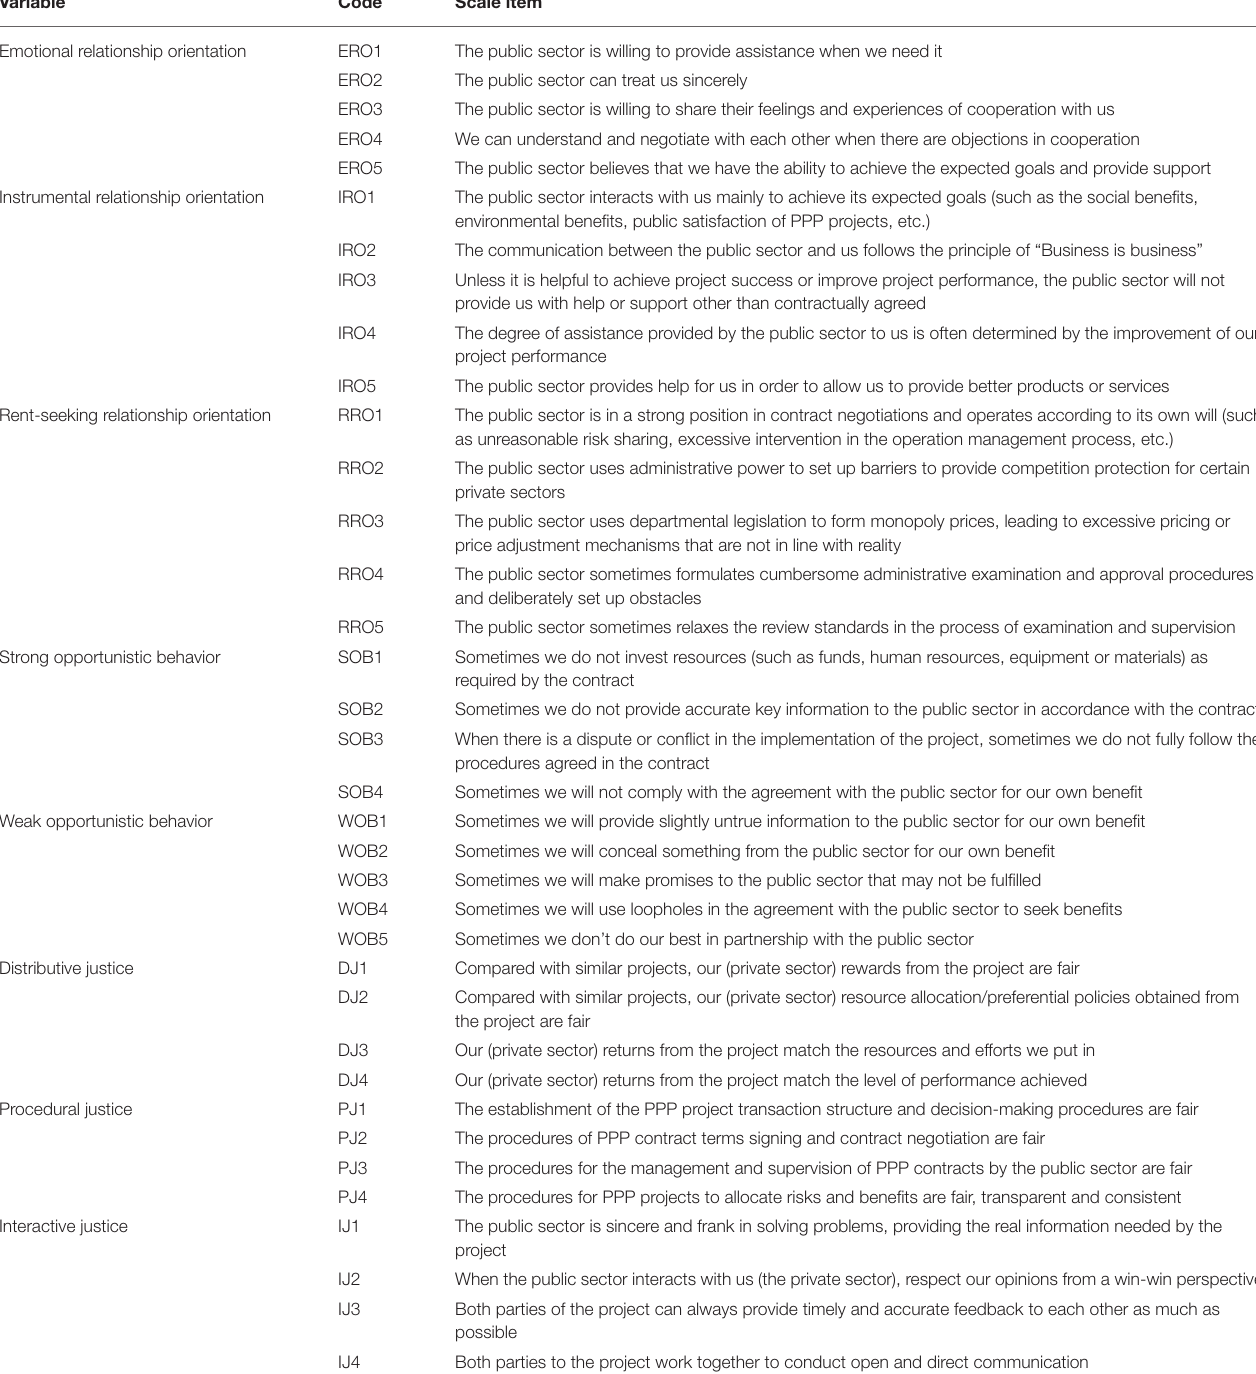
TABLE 2 | List of coded survey items. Variable